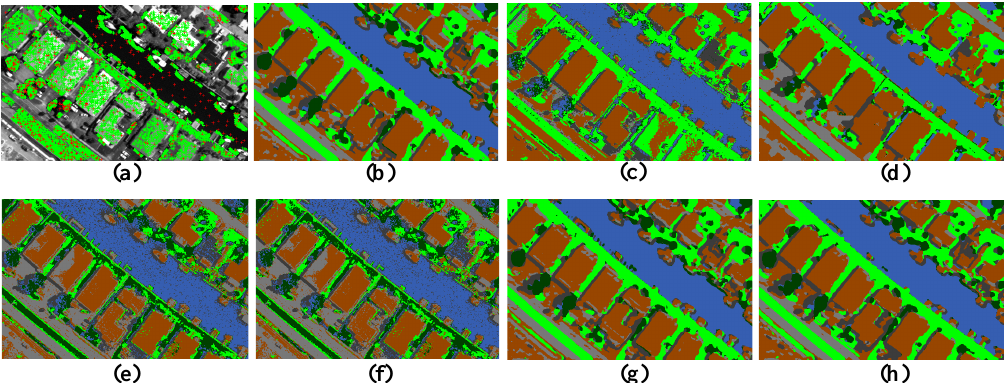
Figure 10. Classification results of the methods for Aerial data: ( a ) Selected training samples (red markers are the initial selected training points, and the green markers are the final selected training points). ( b ) CNNs. ( c ) TSVM. ( d ) SemiMLR. ( e ) SemiSAE. ( f ) Ladder network. ( g ) Spectral-spatial view. ( h ) HMVSSL